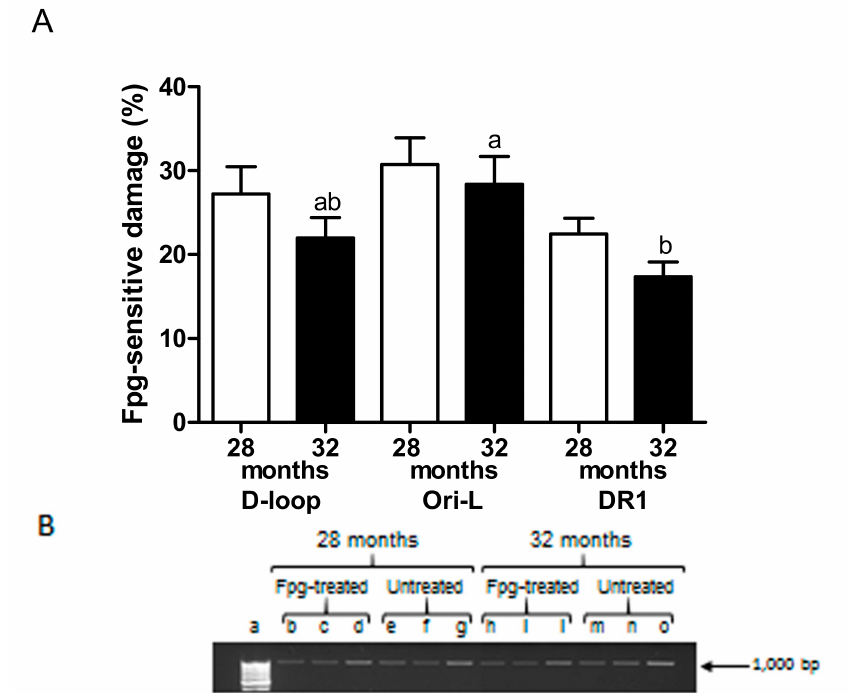
Figure 4. Oxidized purines-specific mtDNA damage at the D-loop, Ori-L, and DR1 regions in liver from 28- and 32-month-old rats. ( A ) Bars represent the mean and SEM of the values obtained for each of the five animals analyzed in both groups. Bars not showing the same superscript di ff er significantly; p < 0.05, Dunn’s Multiple comparison test after Kruskal-Wallis test. ( B ) Representative gel of formamidopyrimidine DNA glycosylase (Fpg)-treated and untreated total DNA from a 28-month-old rat and a 32-month-old animal; 2.5 and 5 ng total DNA were amplified using the D-loop long primer set (Table 1). An aliquot of each PCR amplification was loaded onto agarose ethidium bromide-stained gel and analyzed for band intensities (a: molecular weight marker (GeneRuler 100 bp DNA Ladder, Thermo Fisher Scientific); b, c, e, f, h, i, m, and n: 2.5 ng total DNA as PCR template; d, g, l, and o: 5 ng total DNA as PCR